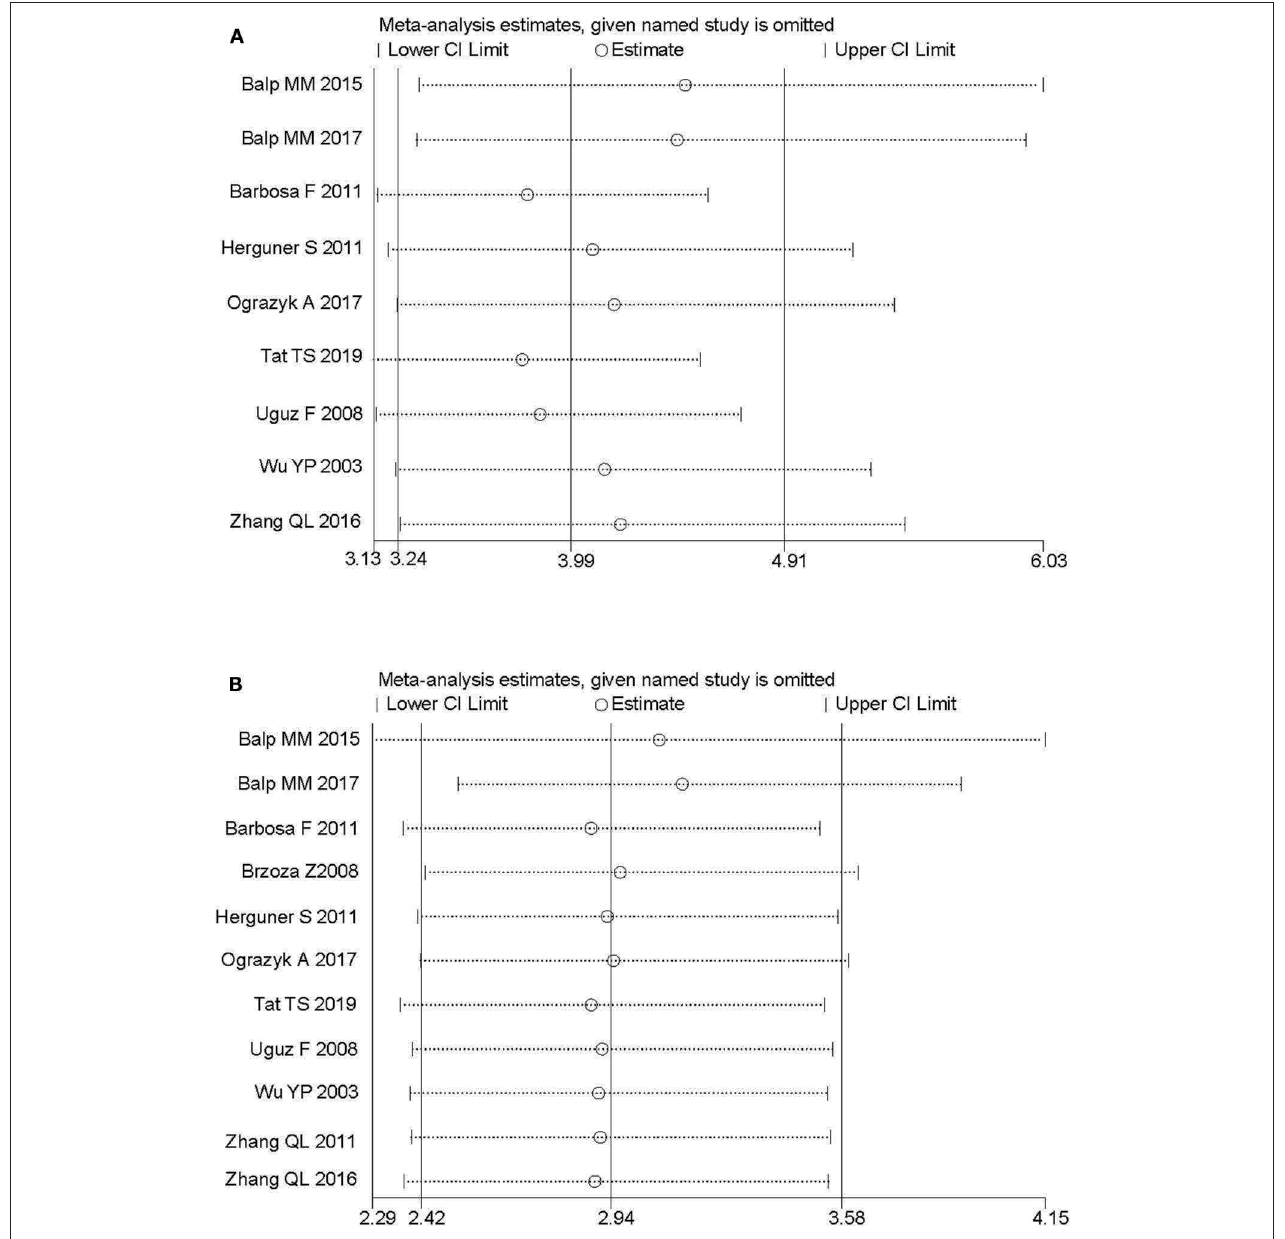
FIGURE 4 | Sensitivity analysis of the pooled estimates by excluding the studies one by one. (A) Anxiety, in terms of odds ratio. (B) Depression, in terms of odds